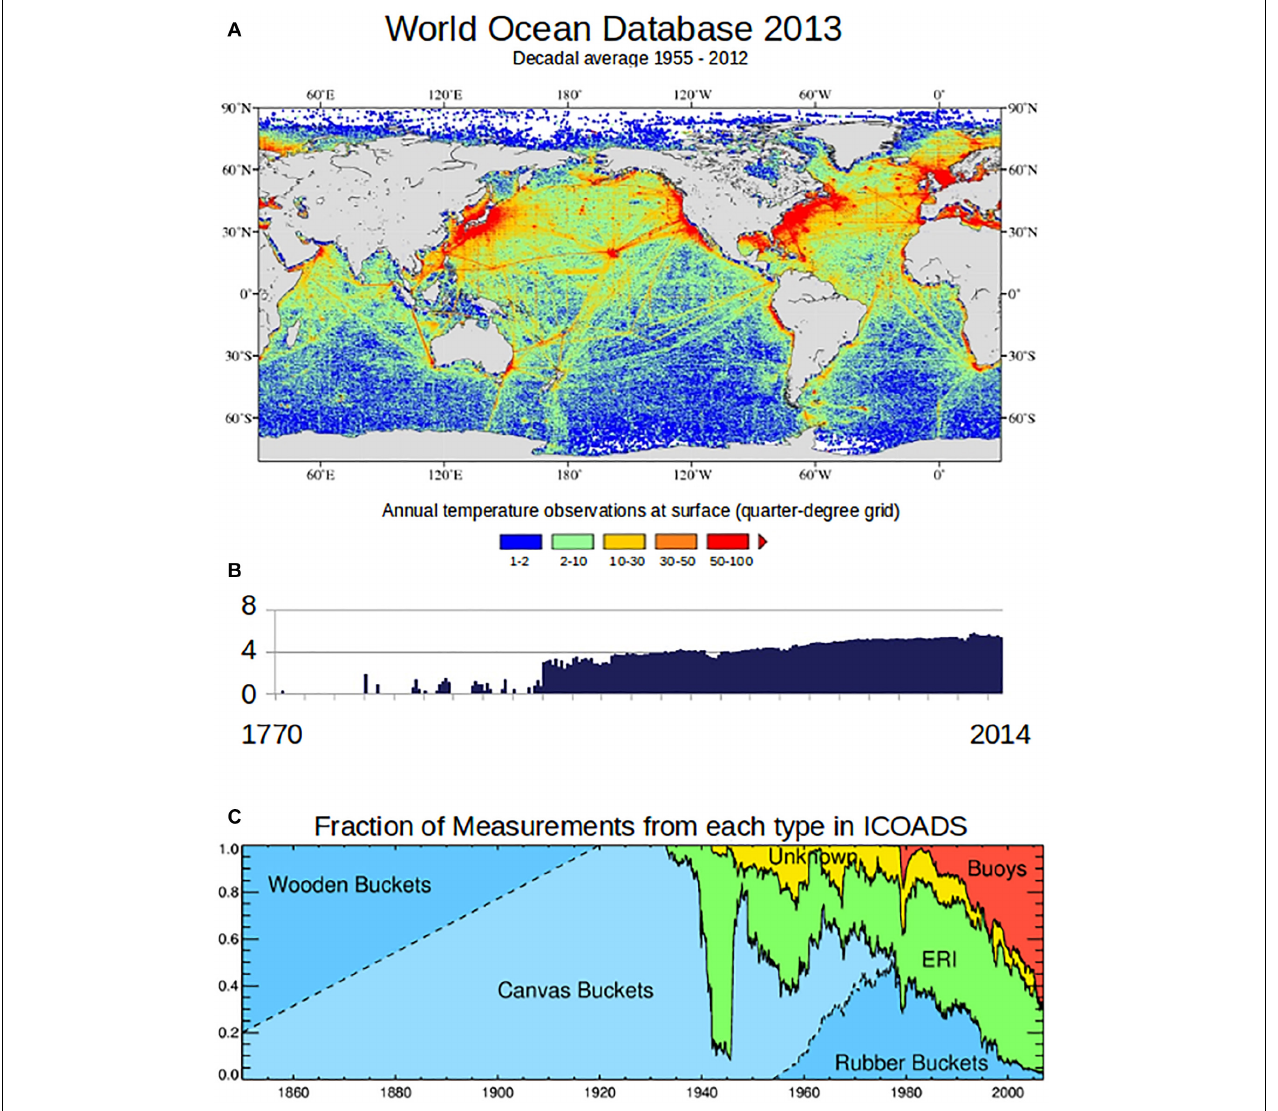
FIGURE 2 | Distribution of SST measurements and by method. (A) Shows the spatial distribution of SST measurements as included in the World Ocean Atlas in 2013. (B) Shows the temporal distribution of SST measurements in the World Ocean Atlas in 2013 (from Freeman et al., 2017). (C) How the measurement methods changed over time. ERI are Engine Room Intake measurements, Buoy measurements include drifting and moored buoys (from Rayner et al., 2018). Please note that the spatial and temporal time lines are different, 1955–2012 for the spatial distribution shown in plate (A) and 1770–2014 for the temporal distribution shown in plate (B)